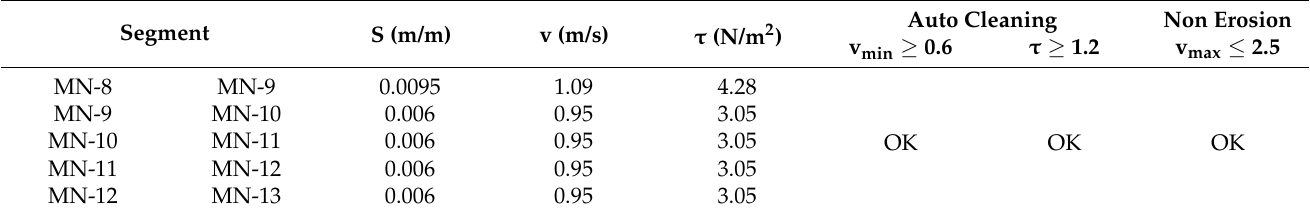
Table 10. Hydraulic parameters of the pipeline connecting to the sewerage system of EA1.